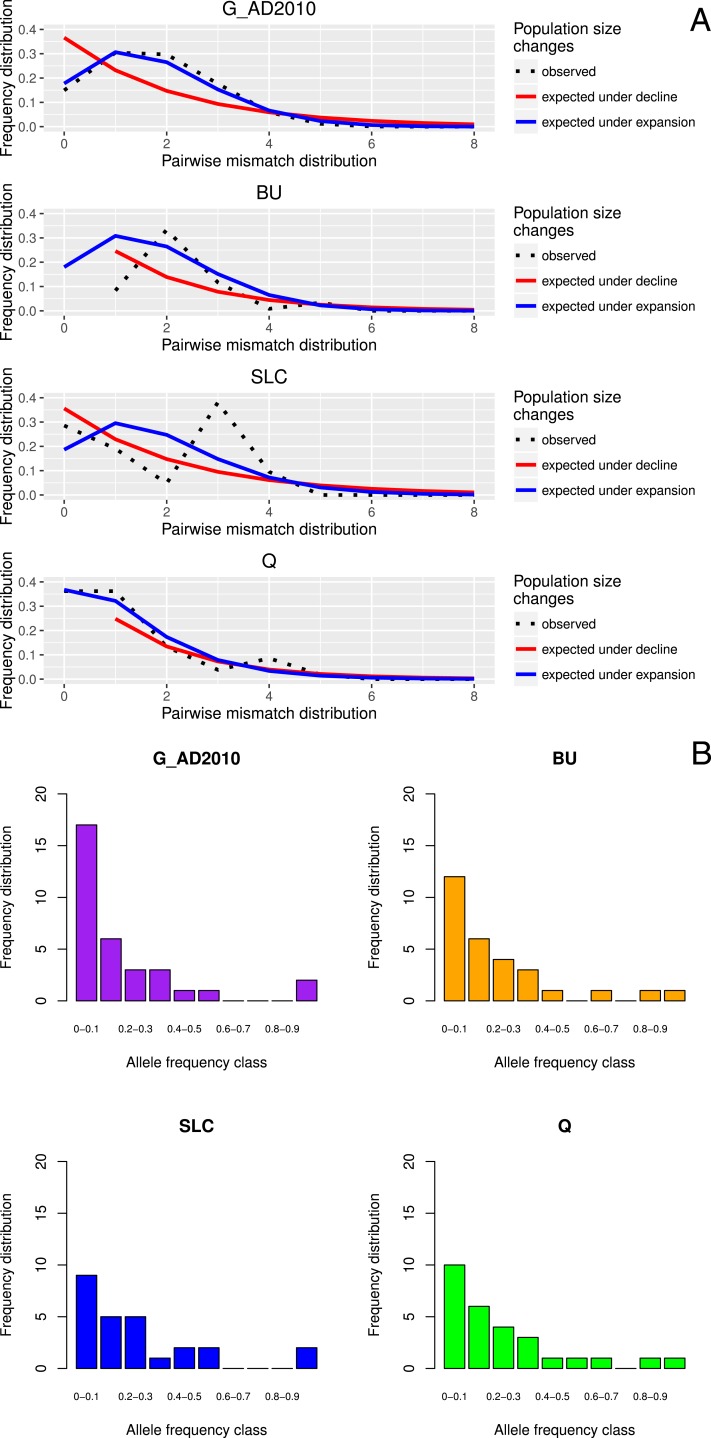
Location-specific demography accessed with neutral evolving markers.Two types of analyses specific to each marker are presented in this figure: mismatch pairwise distribution of mtDNA’s single nucleotide polymorphisms within locations (A), and frequency distribution of allelic states across microsatellite loci (B). The locations here exposed are G_AD2010 (cohort of 2010 from Adour), BU (Burrishole), SLC (LoughComber), Q (Quoile) and were chosen among the others in order to show the variety of demographic signatures produced by mtDNA data. Therefore in mismatch pairwise distribution graphs, full blue lines represent expected distribution under sudden population expansion, full red lines represent expected distribution under constant population size and dotted lines the observed distribution. The x-axis shows the number of mismatches and y-axis its frequency. It is possible to observe the signature of an expanding population in G_AD2010, stable population or recovery from bottleneck BU and SLC, and stable population in Q. Allele frequency distribution plots obtained from same locations show the signature of non-bottlenecked population (B). In these graphs, the bars correspond to allele frequencies, x-axis corresponds to allele frequency classes and y-plots to number of alleles.